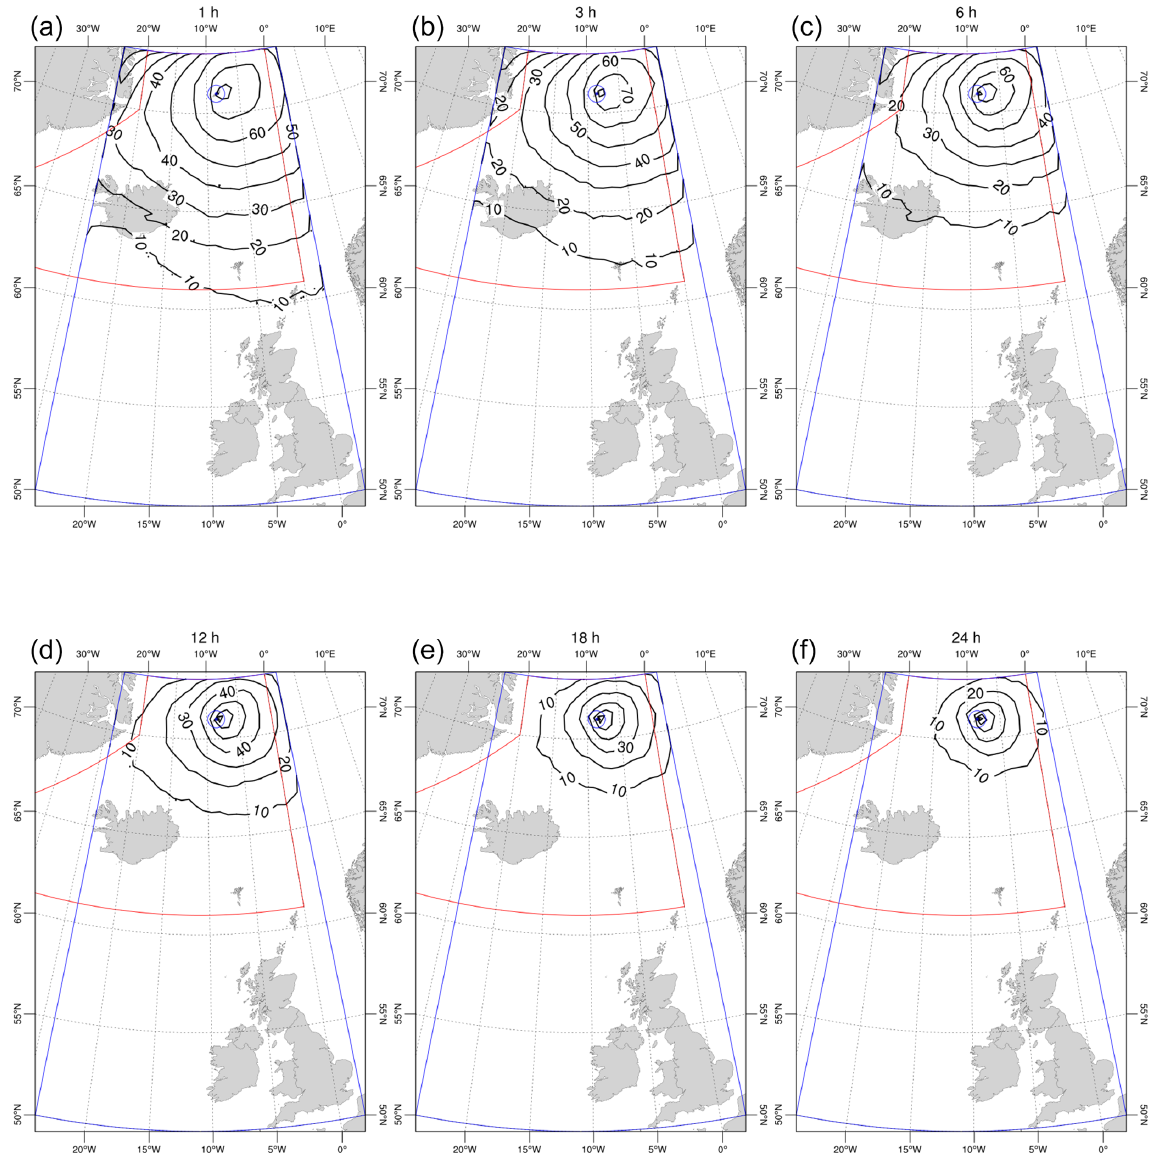
Figure 12. Persistence maps at FL050 (medium class): the isolines show the probability of reaching or exceeding an ash concentration above 2mgm − 3 at FL050 for 1, 3, 6, 12, 18, and 24h during the eruption and to up to 48h after its